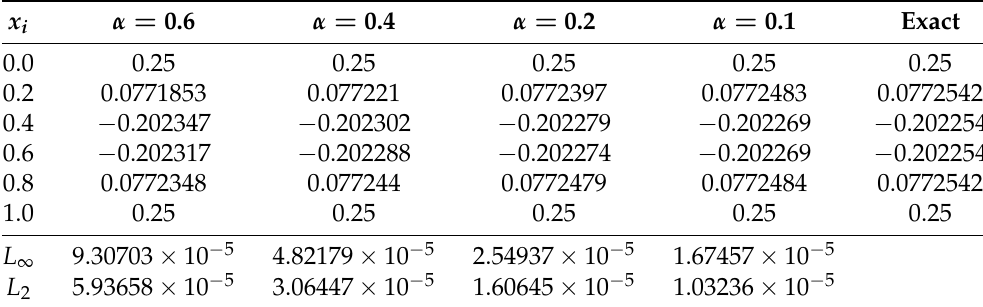
Table 7. Error norms, numerical solutions and comparison of the exact solution of imaginary part of